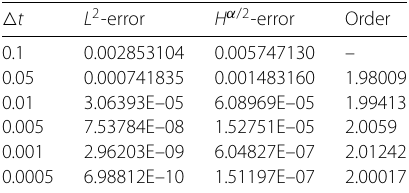
Table 1 The L 2 and H α /2 numerical errors at α = 1.5 for various temporal resolutions u